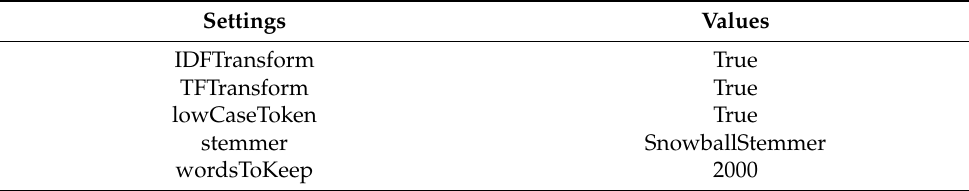
Table 3. The settings of the Naïve Bayes Multinomial model